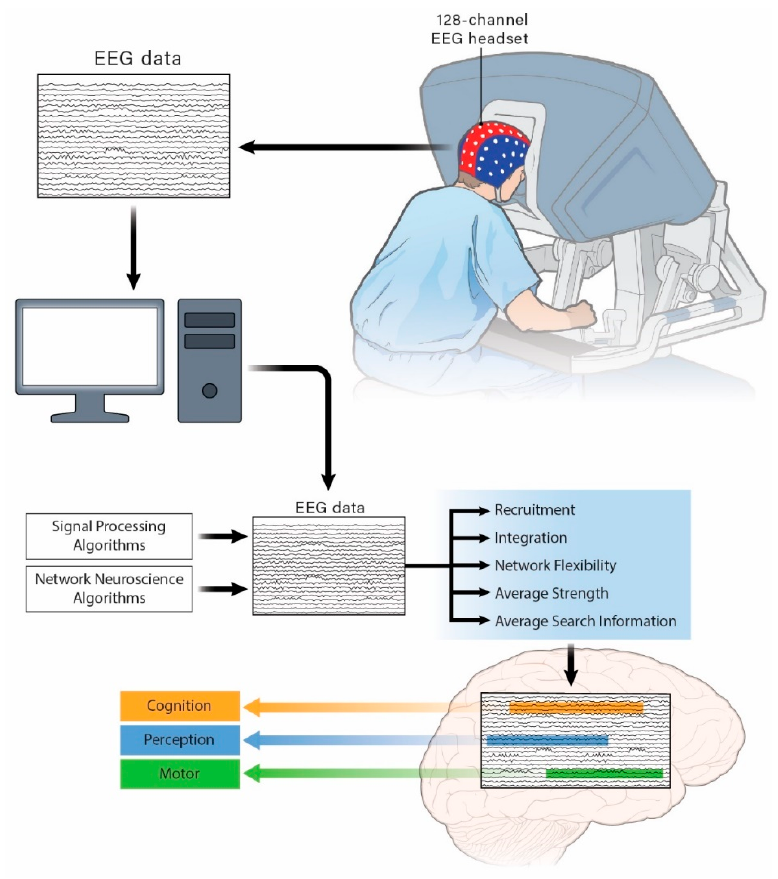
Figure 1. Schematic of the experimental setup and extraction of electroencephalogram (EEG) features within “motor process-related areas”, “cognitive process-related areas”, and “perceptual process-related areas”.